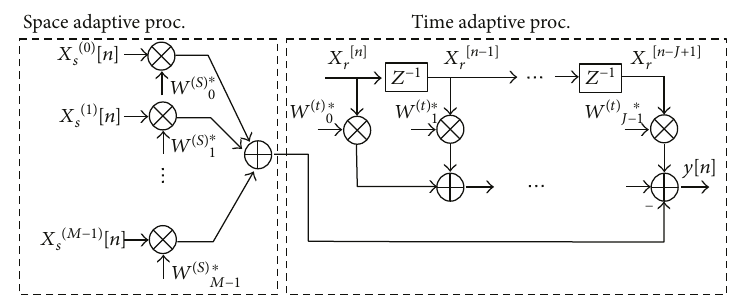
Figure 3: Temporal after spatial fi